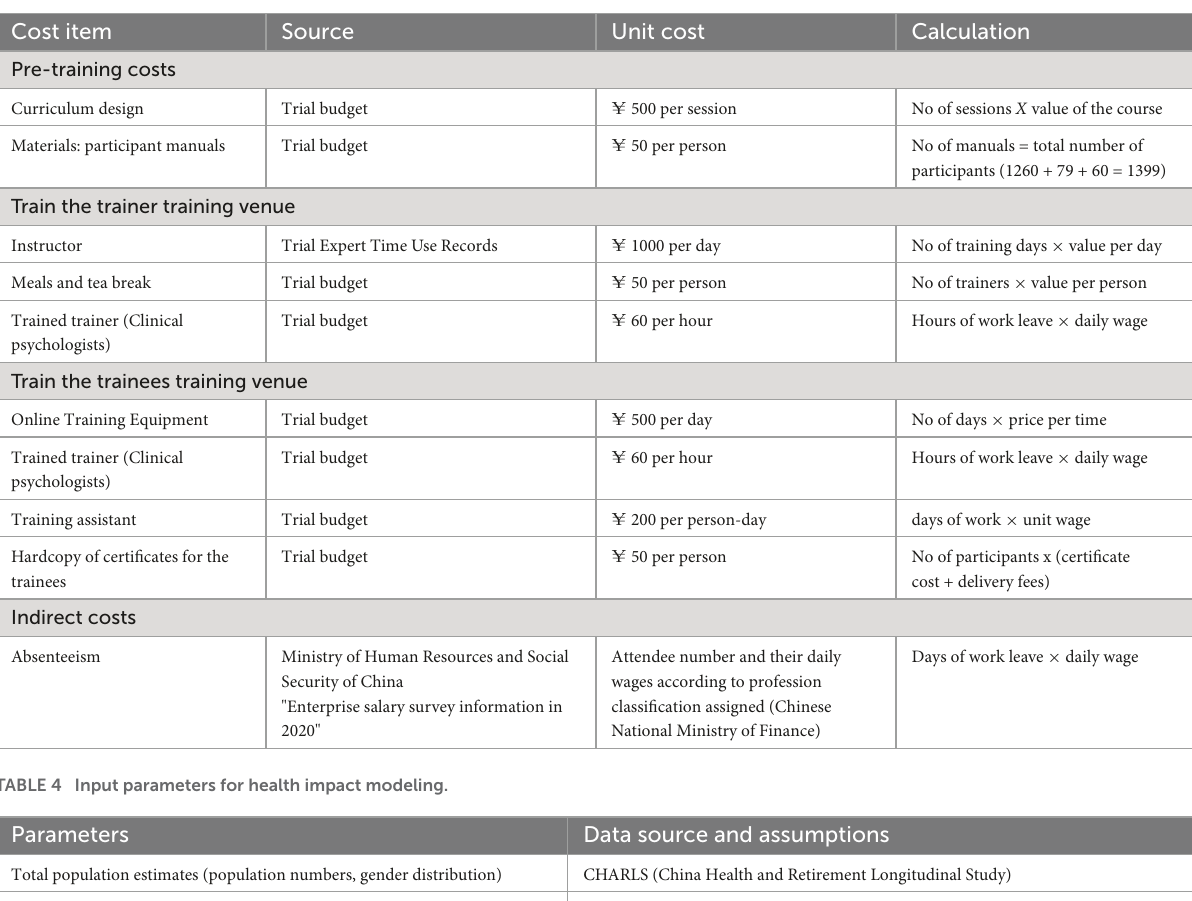
TABLE 3 Resource use and intervention costs.